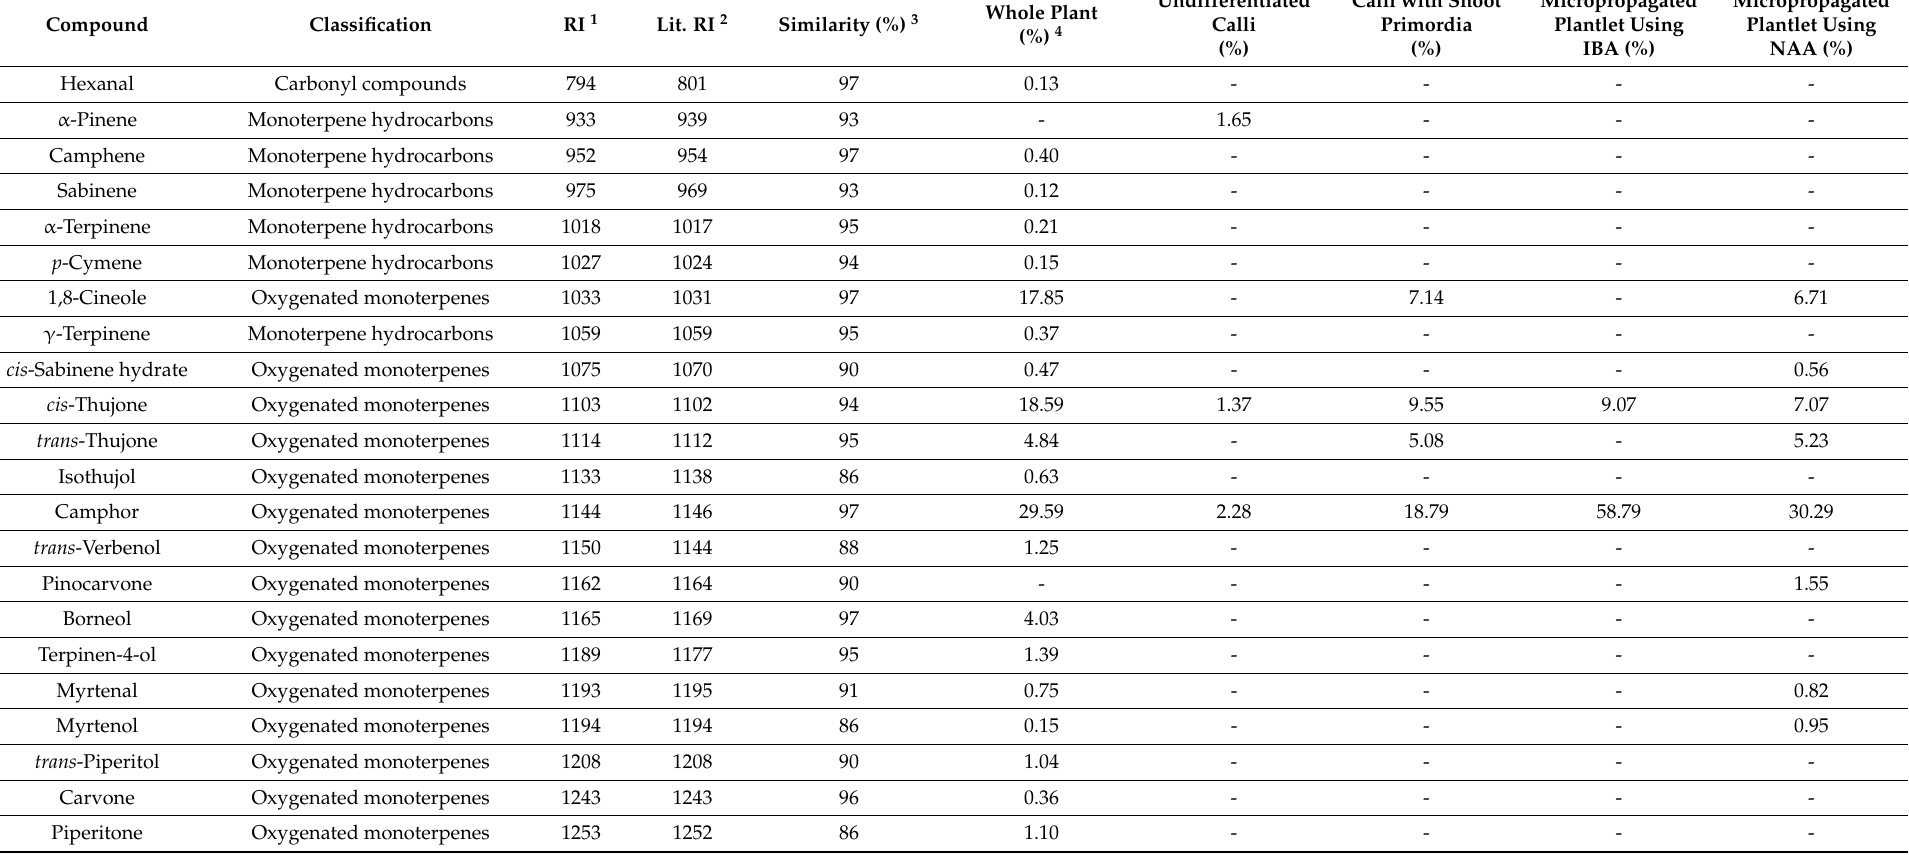
Table 3. Volatile organic compounds (VOCs) identified in different extract samples of Artemisia spicigera